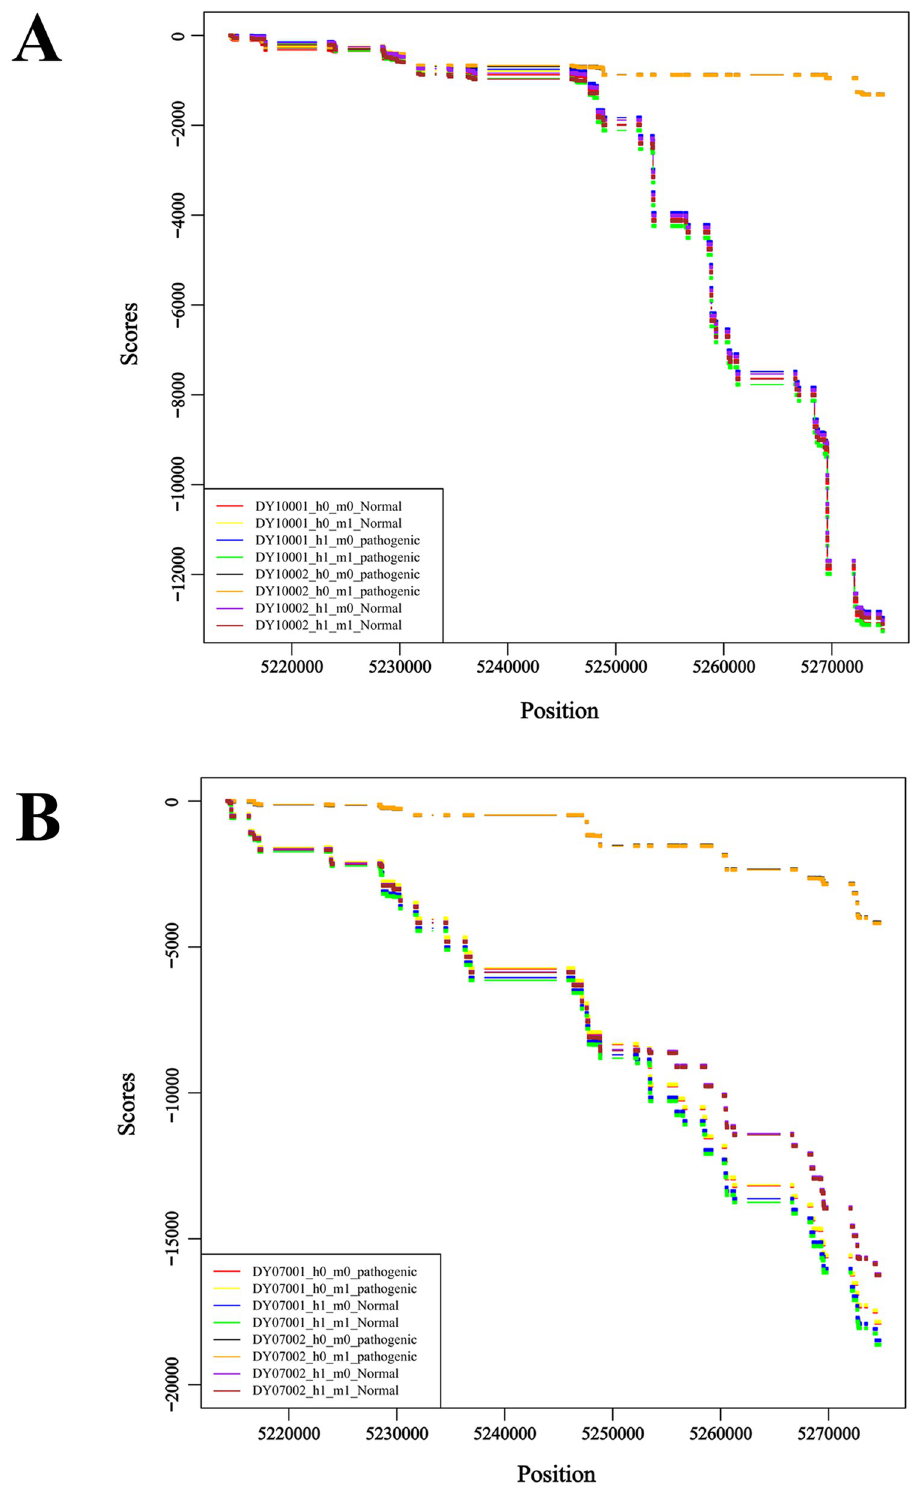
Fig 1. Diagram of pseudo-tetraploid genotype prediction using the original and optimized methods in sample DY07001. The pathogenic haplotypes of the known parental carrier were annotated as H1, while the normal haplotypes were grouped as H0. The pathogenic haplotypes of the offspring were marked as M1 and the healthy haplotype as M0. (A) The most likely combination of maternal-fetal genotypes (orange and black) predicted using the